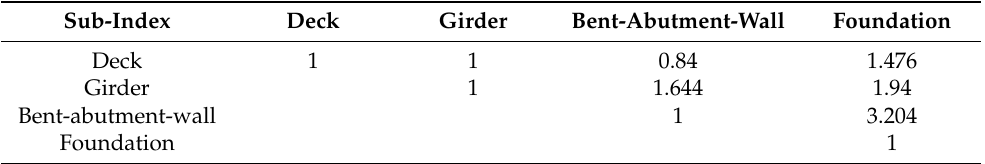
Table 8. Relative importance of sub-indices in structural index.